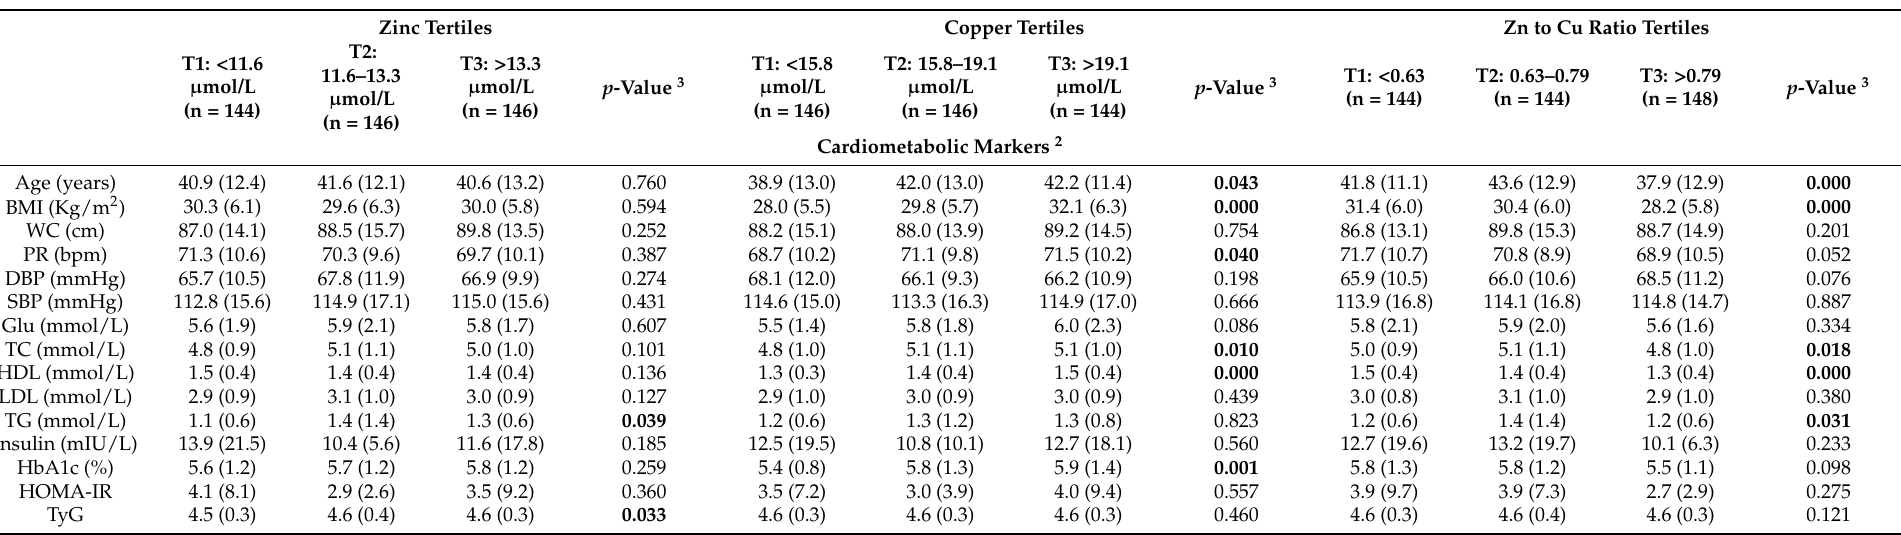
Table 2. Comparison of cardiometabolic markers according to serum Zn, Cu, and Zn to Cu ratio 1